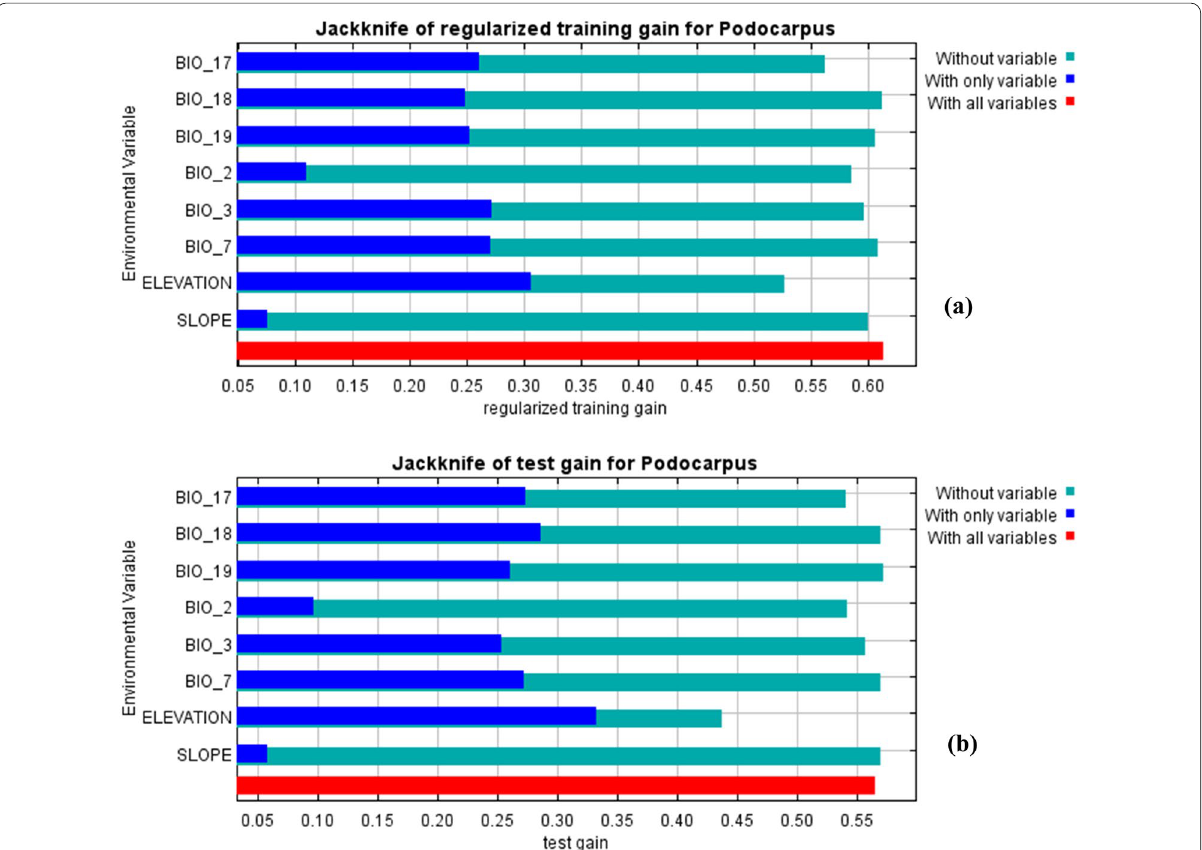
Fig. 4 Jackknife importance of variables in predicting distribution of P. falcatus : a for training data b for test